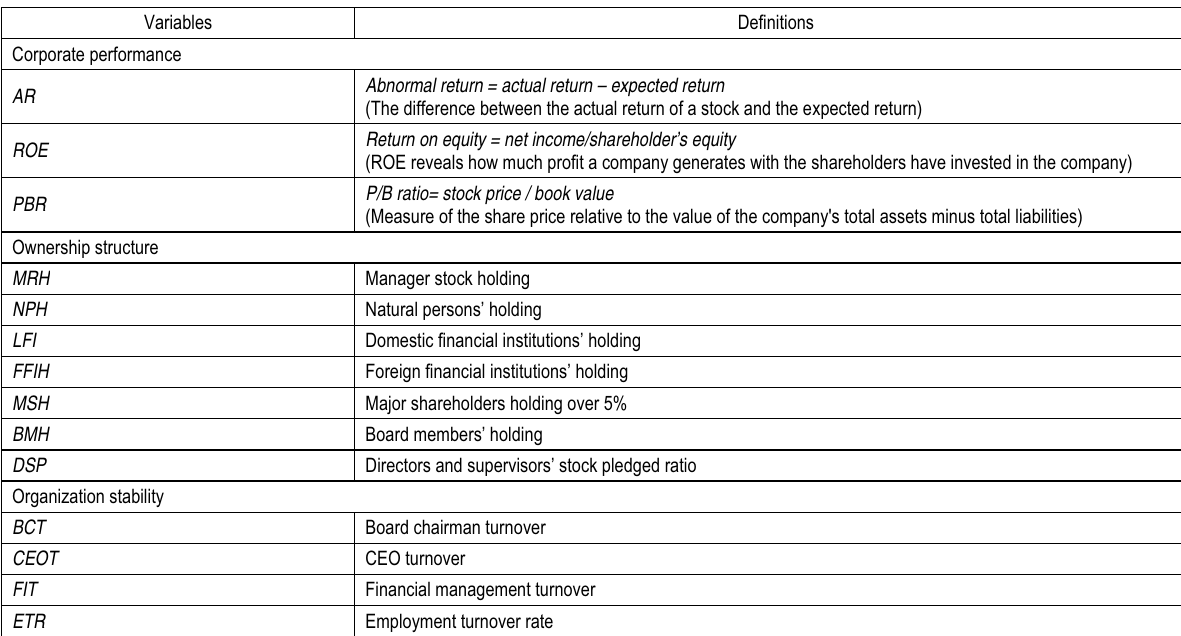
Table 1. The definitions of